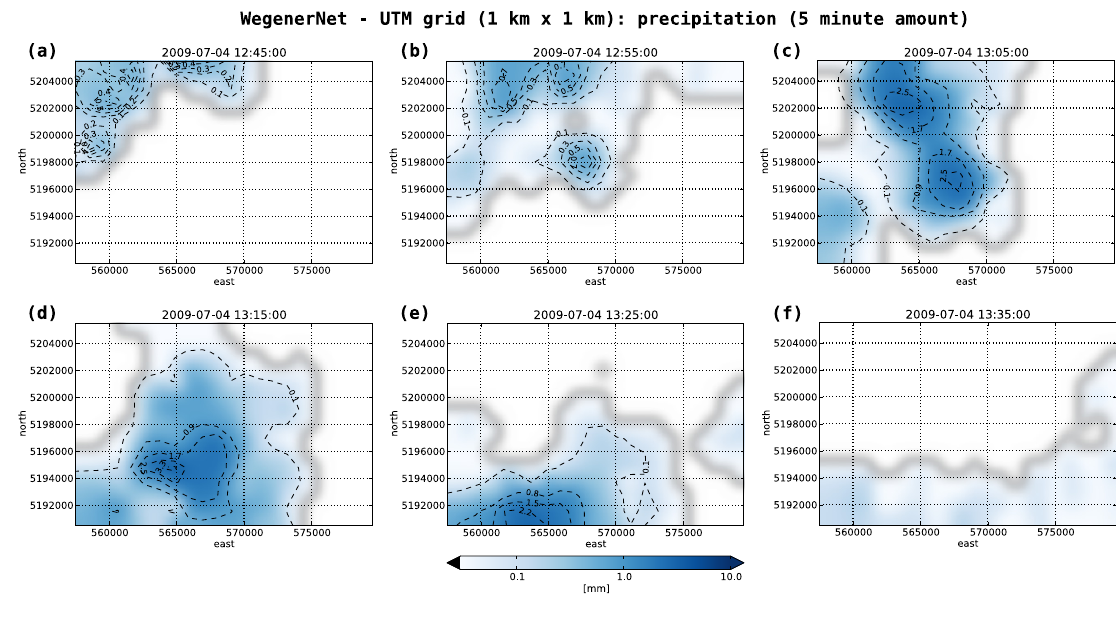
Figure 4. Temporal and spatial variability of precipitation on 4 July 2009, at 1km resolution in UTM coordinates (dotted lines). Amounts with 5min sampling are shown on a logarithmic scale at every second timestep within one